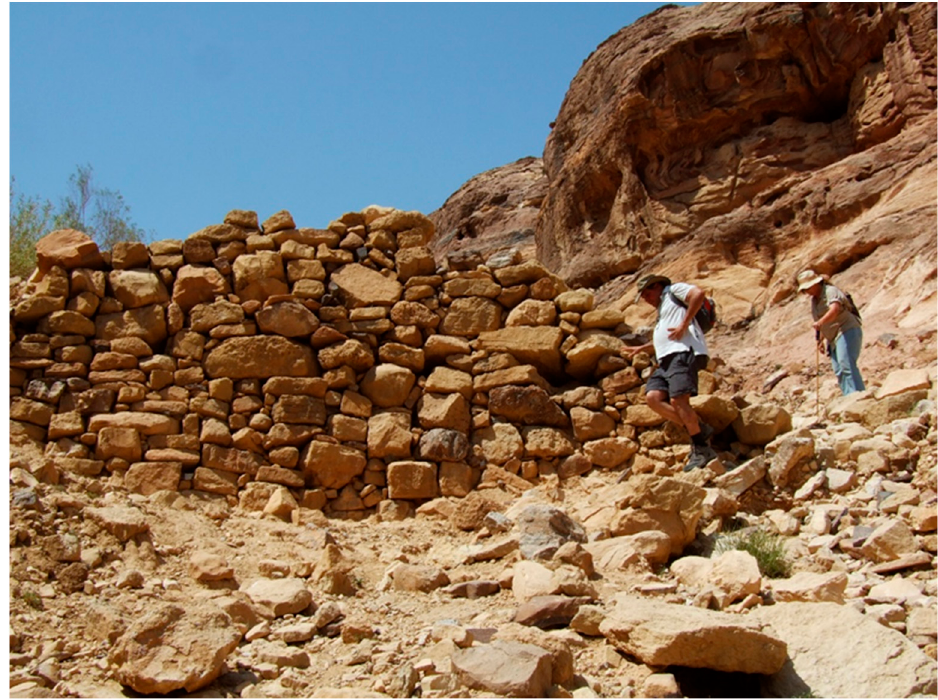
Figure 10. Ancient Type B agricultural terrace in the Petra region, constructed from massive limestone and chert slabs. Note the uneven collection, probably indicating several events of collapse and reconstruction. (Photograph: Y. Avni).